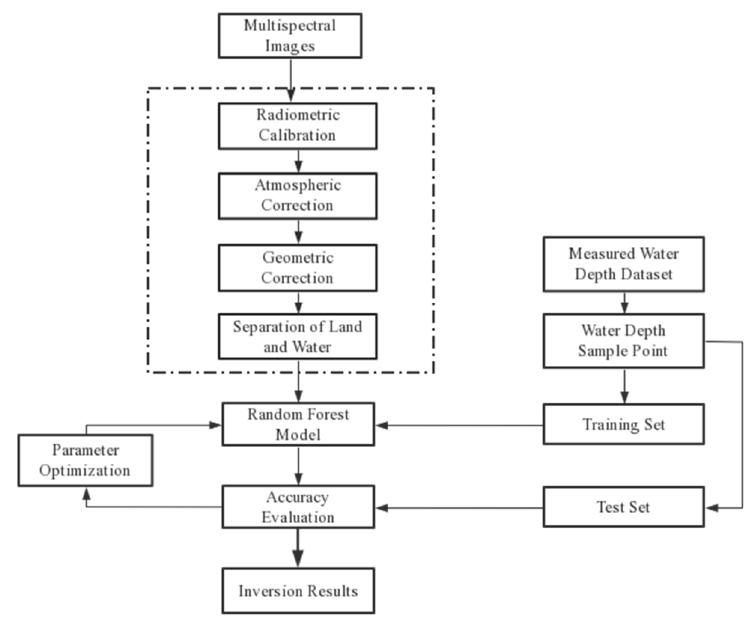
Figure 5. Flow chart of multi-spectral remote sensing data water depth inversion technology .